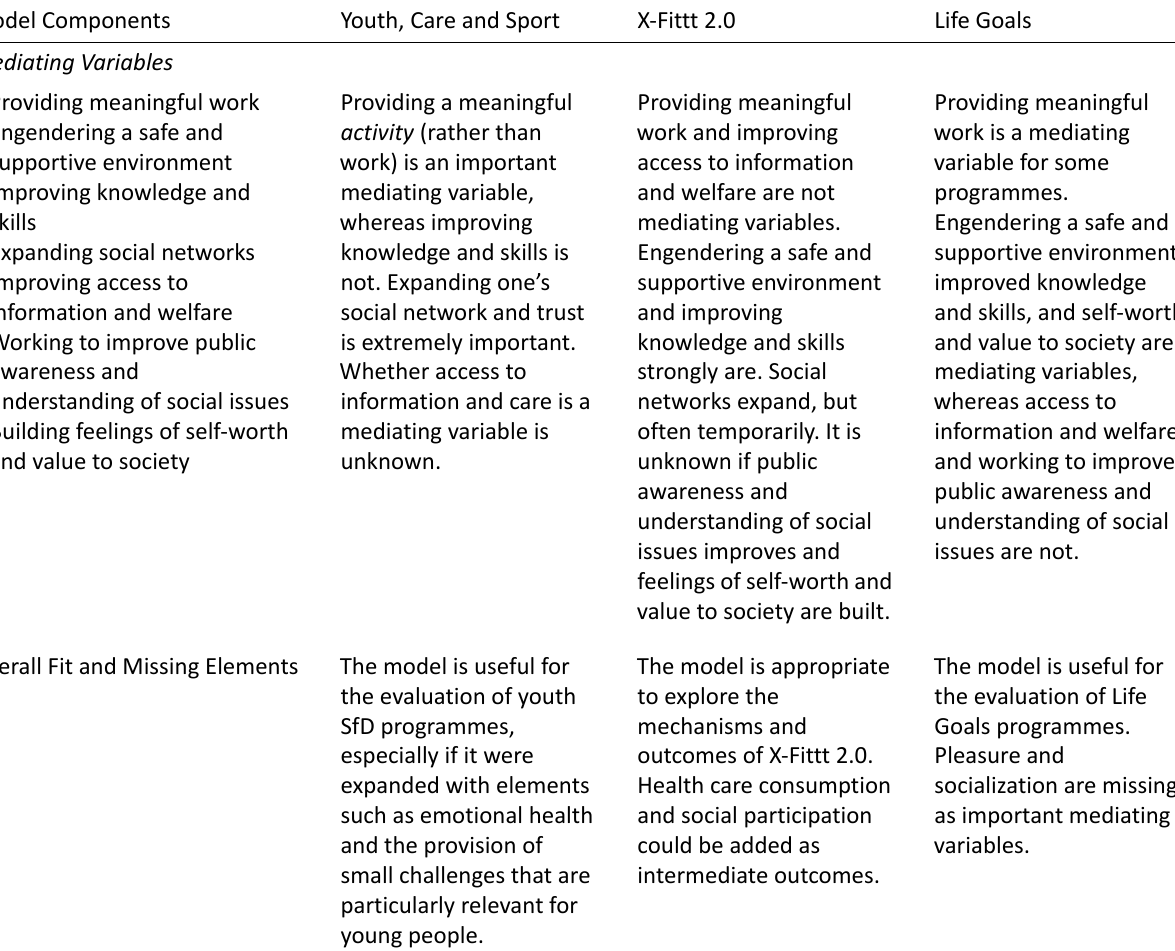
Table 1. (Cont.) Respondents’ reflections on the applicability of the model by Roy et al. (2017) to ‘their’ SfD